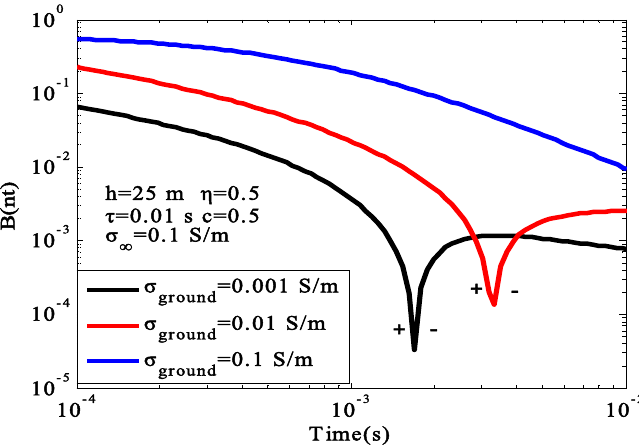
Figure 11. IP effects under different background conductivities. Figure 11. IP e ff ects under di ff erent background